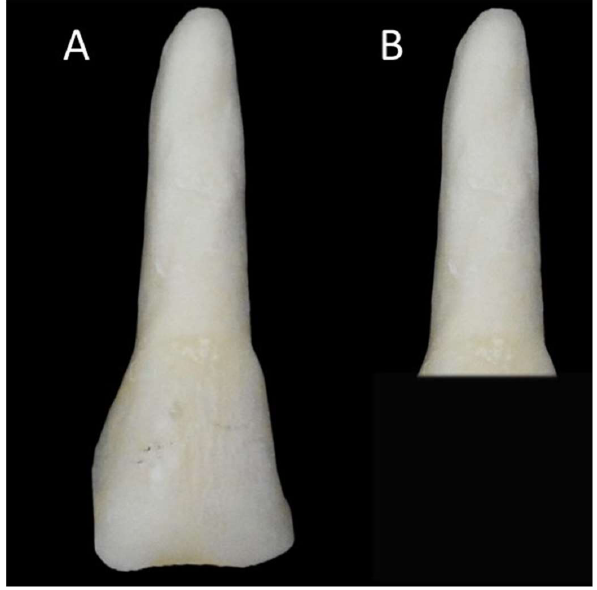
Figure 1. Cleaned bovine tooth ( A ) and decoronated tooth ( B